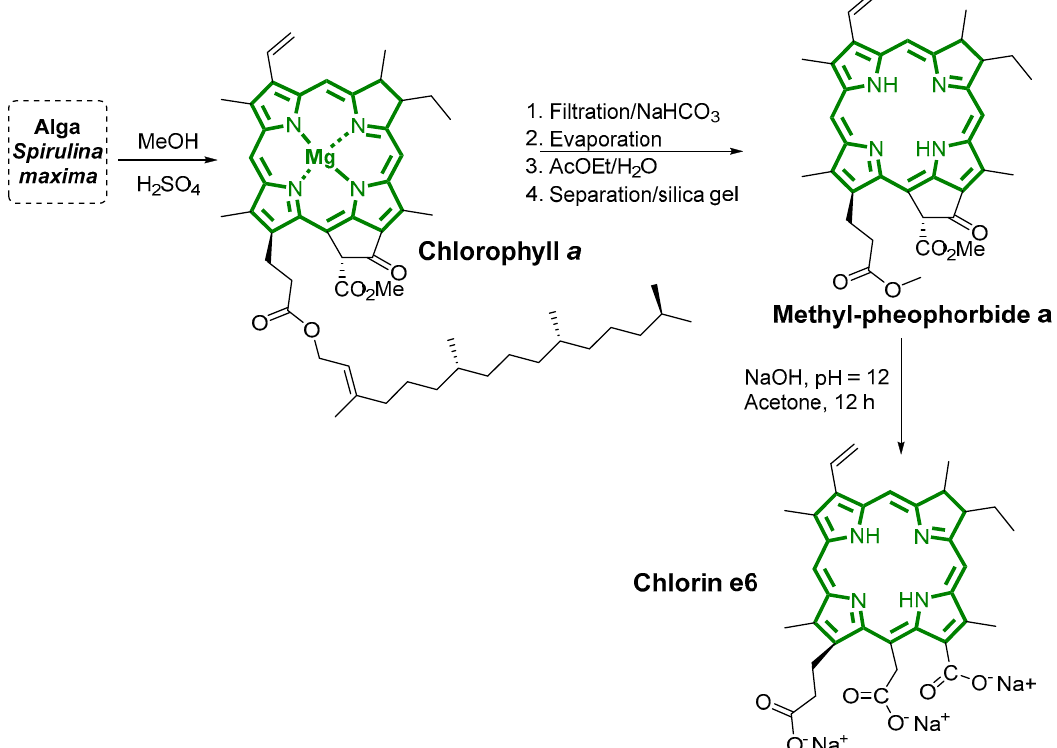
Figure 6. Methodology for the chlorin e6 extraction from Spirulina maxima .